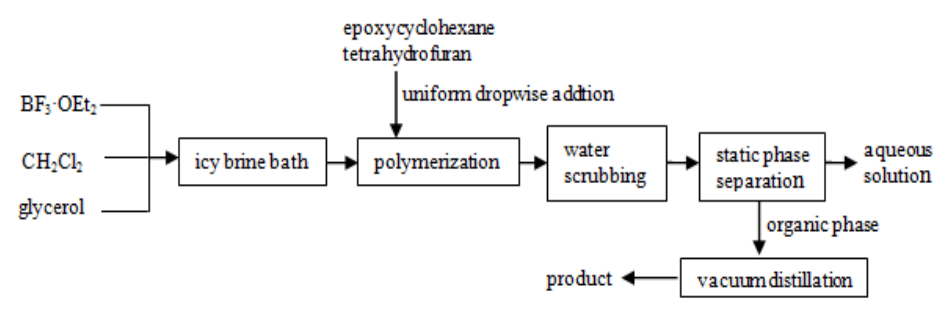
Figure 2. Synthesis process of copolyether.